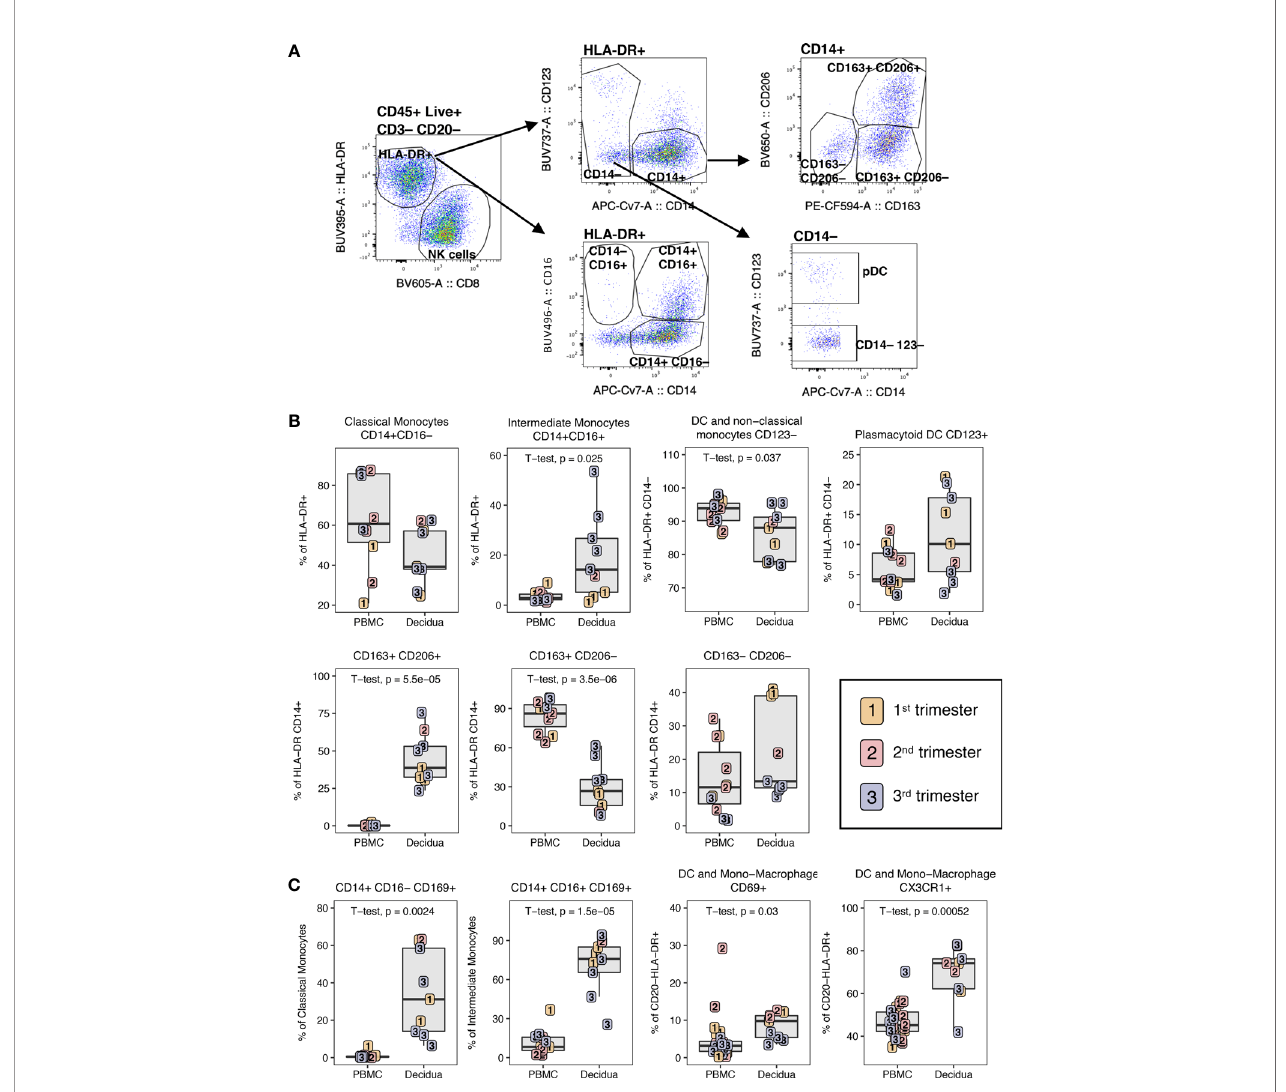
FIGURE 9 | Phenotype of dendritic cells and monocyte/macrophage in PBMC and decidua of normal pregnant rhesus macaques. (A) Representative fl ow plot and gating of HLA-DR+ myeloid cells. (B) Frequency of monocyte/macrophage and DC subsets in PBMC and decidua fi rst (yellow), second (red) and third trimester (blue) of normal pregnant rhesus macaques. (C) Phenotype of monocyte/macrophages and DCs with box plots showing their frequency. P-values < 0.05 (unpaired t-test) shown on the